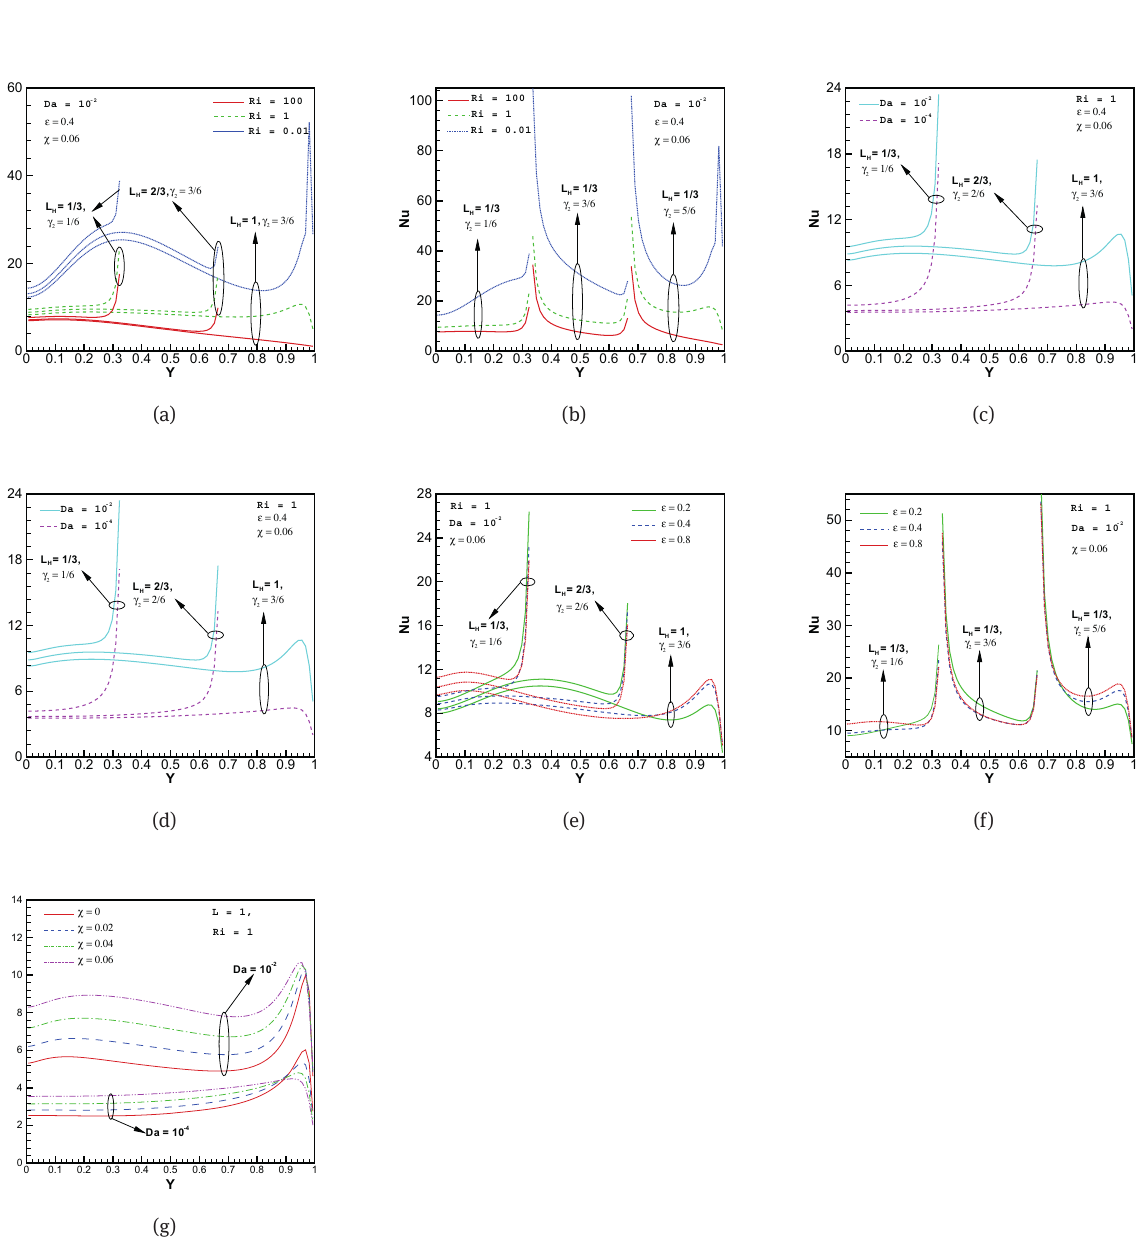
Fig. 9: Local Nusselt numbers: (a-b) the effects of Ri , (c-d) the effects of Da , (e-f) the effects of ϵ , with different L H and γ 2 , and (g) the ef- fects of χ with different Da